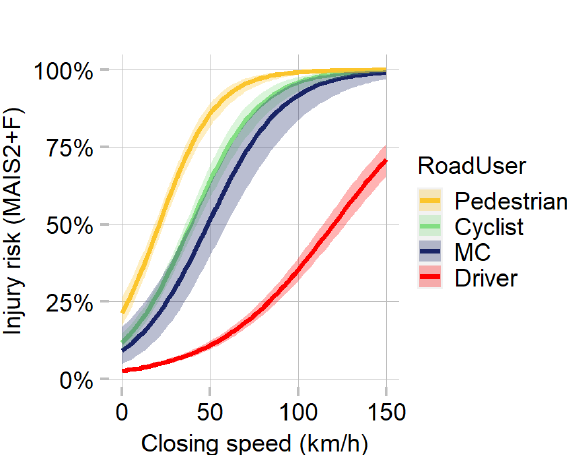
Figure 5. MAIS2+F injury risk curves with confidence levels, for different road users at 65 years of age